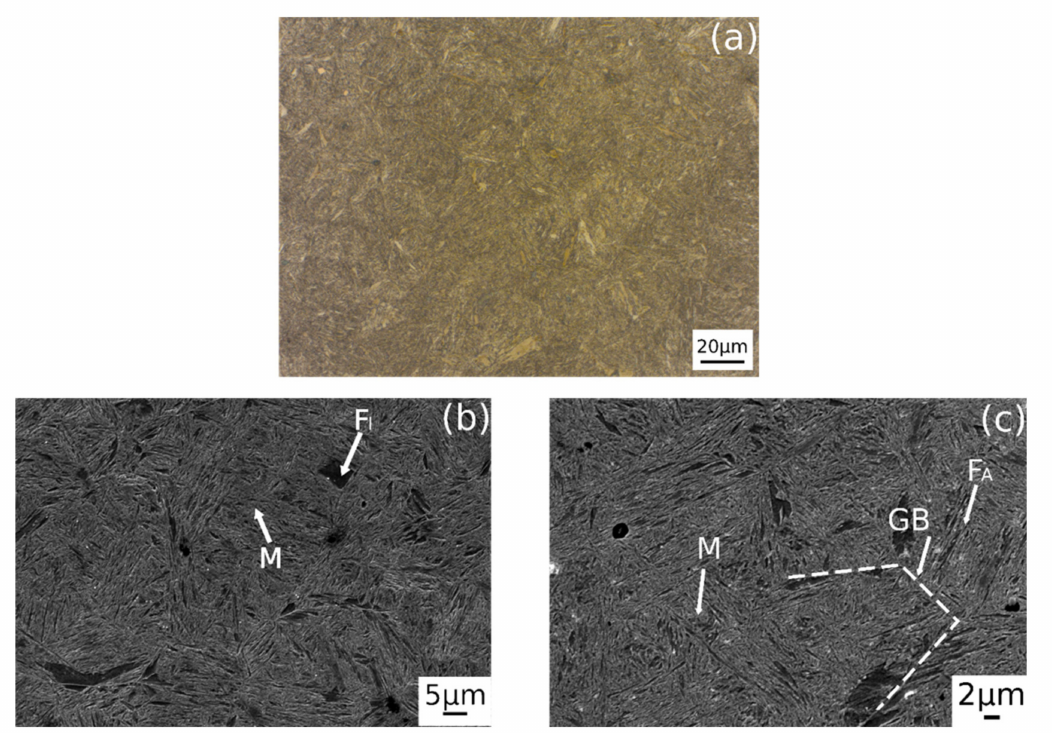
Figure 4. Optical ( a ) and SEM ( b , c ) micrographs showing the microstructure of the material in as-received state.